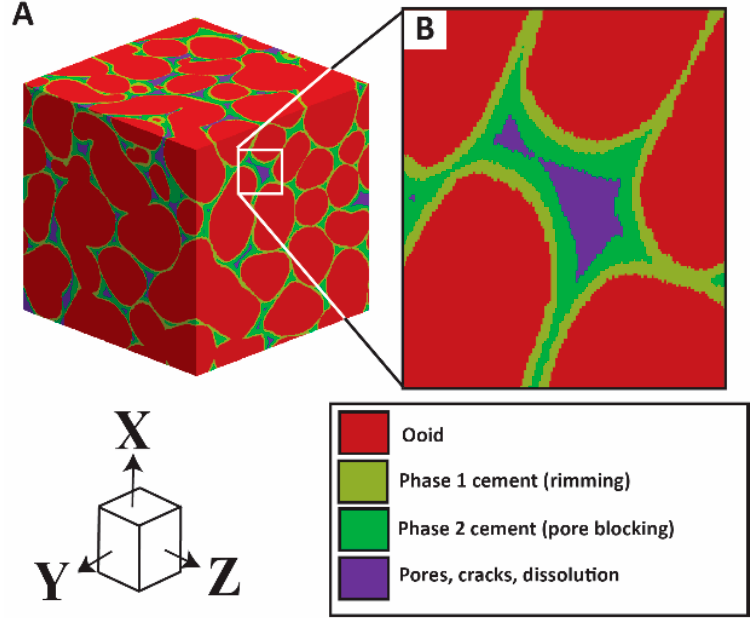
Figure 3. Key to coloured 3D models (colourised using ‘Rainbow’ LUT in Slicer software). Note that due to the vagaries of the software, that though phase 1 cement is colourised yellow here, it appears green in models where only phase 1 is present.